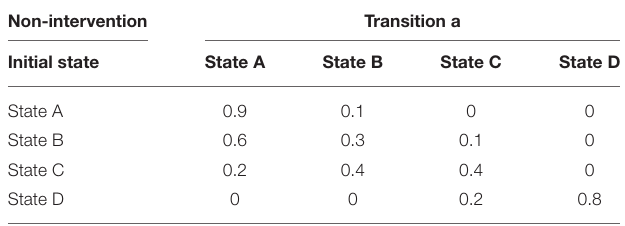
TABLE 1 | Probabilities of transition between non-intervention states.